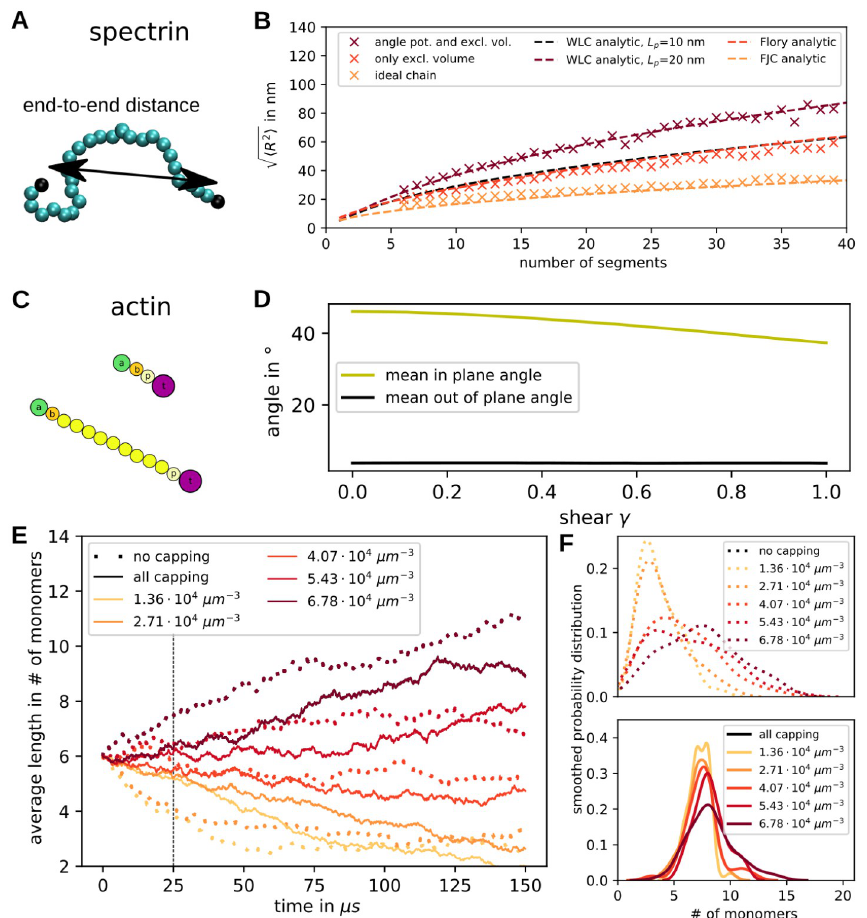
Fig 3. Spectrin and actin filaments. (A) Spectrin properties are tested by examining the end-to-end distance exemplified by the double arrow. (B) The root-mean-square value of the end-to-end distance is calculated for varying filament length. Simulations with an angle potential and excluded volume (wine) are compared to ones without angular confinement in red and simulations of ideal chains (i.e. no angle or excluded volume interactions) in orange. Additionally, we plot the analytic expression for the WLC (wine), the Flory theory (red) and the freely-joined chain (orange). (C) Capped actin filaments of different lengths. (D) The orientation of actin filaments within a network is quantified by the in-plane angle (orientation within the membrane) and the out-of-plane angle (angle in z-direction). These are plotted as a function of shear of the network. (E) The temporal evolution of actin filament average length is plotted for different initial values of G-actin concentration. The solid line shows the data from simulations containing capping proteins and the dotted lines show data from simulations without capping proteins. Each line corresponds to one simulated network with 46 actin filaments. The dashed vertical line indicates the time point for which the distributions are shown in F. (F) The smoothed probability distributions of the filament lengths at time 25 μ s are shown for all concentrations. At the top the data is shown for simulations without capping proteins and at the bottom with capping